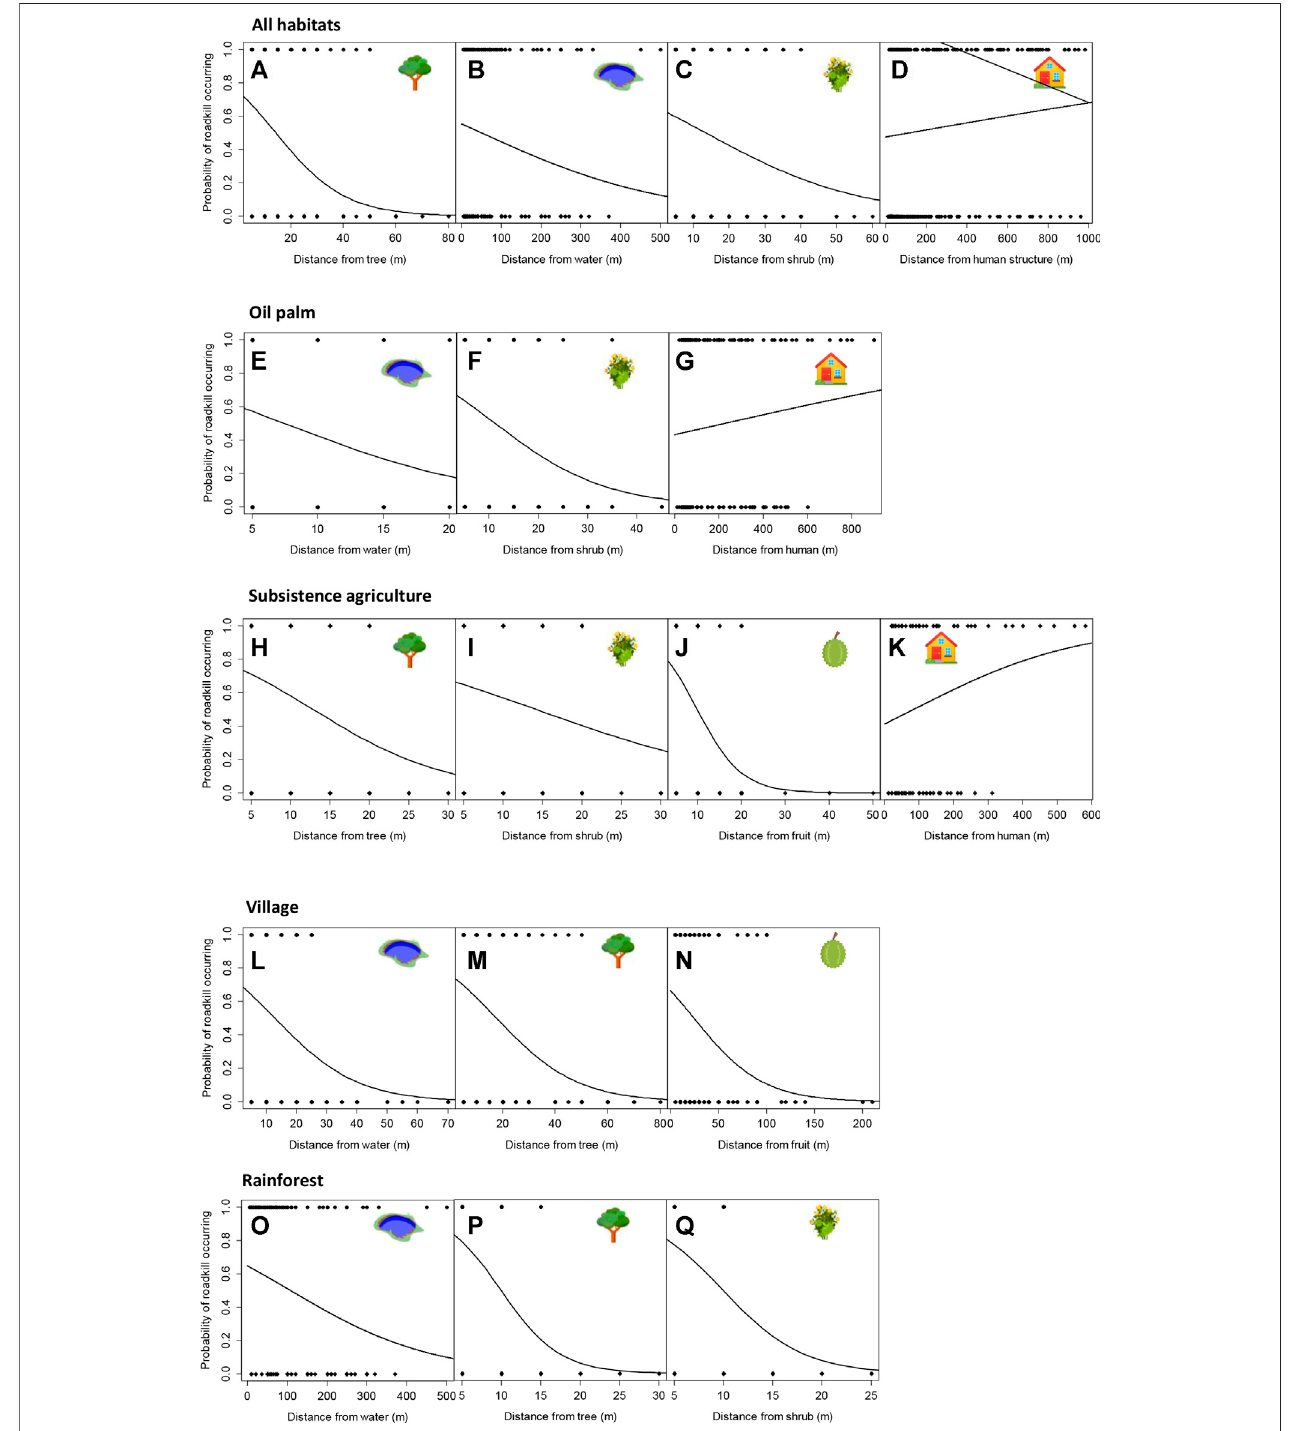
FIGURE2| Probabilitythataroadkillwilloccurwithincreasingdistancefromthenearestwaterbody (A) ,tree (B) ,shrub (C) orhumandwelling (D) inallhabitatsand for all taxa combined; water body (E) , shrub (F) or human dwelling (G) in oil palm habitat; tree (H) , shrub (I) , fruit tree (J) or human dwelling (K) in subsistence agriculture habitat; water body (L) , tree (M) or fruit tree (N) in village habitat; and water body (O) , tree (P) or shrub (Q) in rainforest habitat.